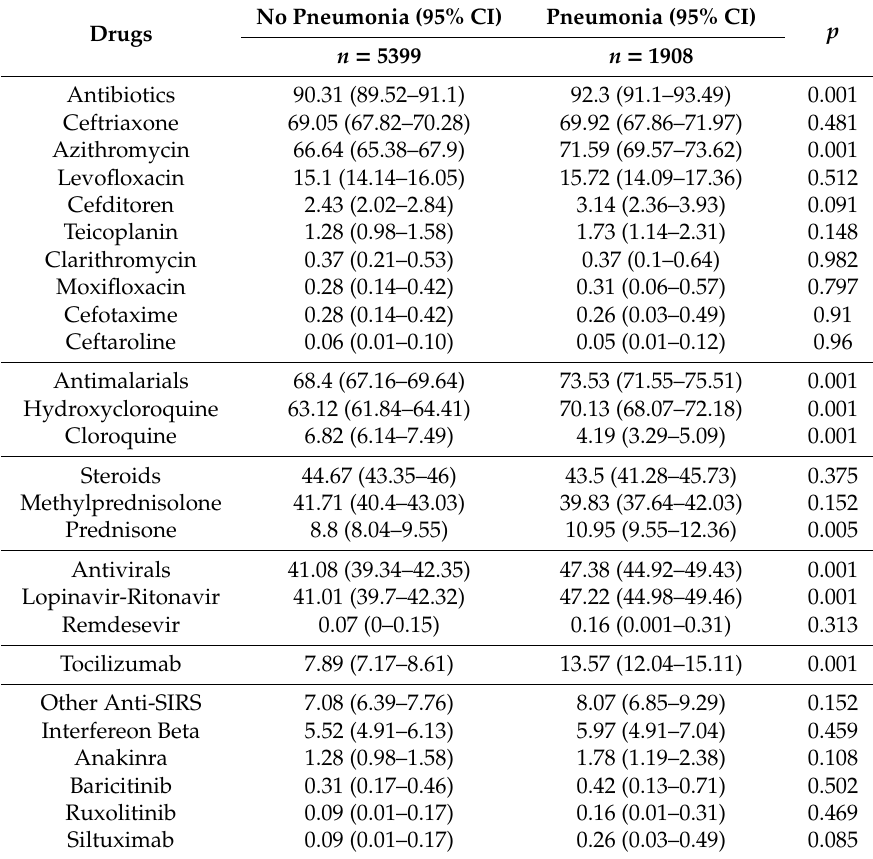
Table 4. Pharmacological treatment in hospitalized COVID-19 patients, with and without pneumonia, in Castile and Leon (Spain) during the first wave (1 March to 31 May